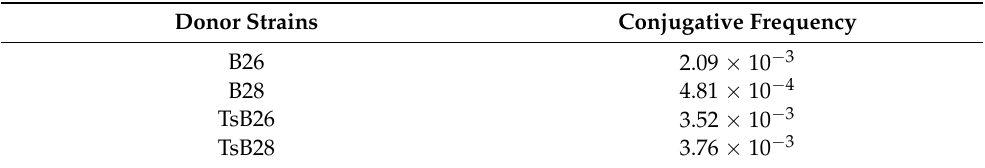
Table 1. Conjugative transfer rates of pTsB26 from different donor strains to Escherichia coli XL1- Blue